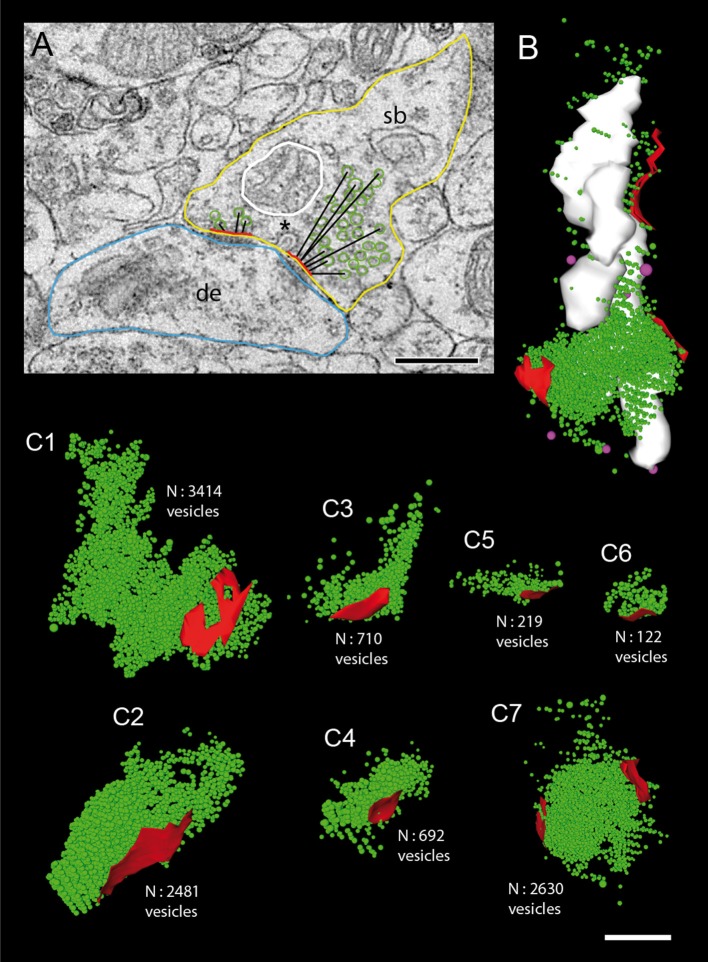
Size of the total pool of synaptic vesicles at individual L5B excitatory synaptic boutons. (A) Quantitative analysis of structural parameters relevant for synaptic transmission and plasticity. The following presynaptic parameters were measured: size of the presynaptic bouton (yellow contour), the PreAZs (red lines), and mitochondria (white contour) and the shortest geometric distance from the center of gravity of synaptic vesicles to the PreAZ (black lines) as shown for a subset of vesicles. Note the fused coated pit (asterisk) at the PreAZ. Abbrevations: de, dendrite; sb, synaptic bouton. Scale bar: 0.25 μm. (B) 3D-volume reconstruction of the total pool of synaptic (green dots) and dense-core (magenta dots) vesicles distributed at three individual PreAZs (red). Note the arrangement of mitochondria (white) in close proximity to the total pool of synaptic vesicles. (C1–C7) 3D-reconstructions of individual total pools of synaptic vesicles (green dots) at PreAZs (red). Note the huge differences in the total pool size between individual synaptic boutons. At one synaptic bouton (C7) the pool of synaptic vesicles is shared between two separated PreAZs. No cluster-like arrangements of synaptic vesicles at individual PreAZs were found. Scale bar: 0.25 μm.